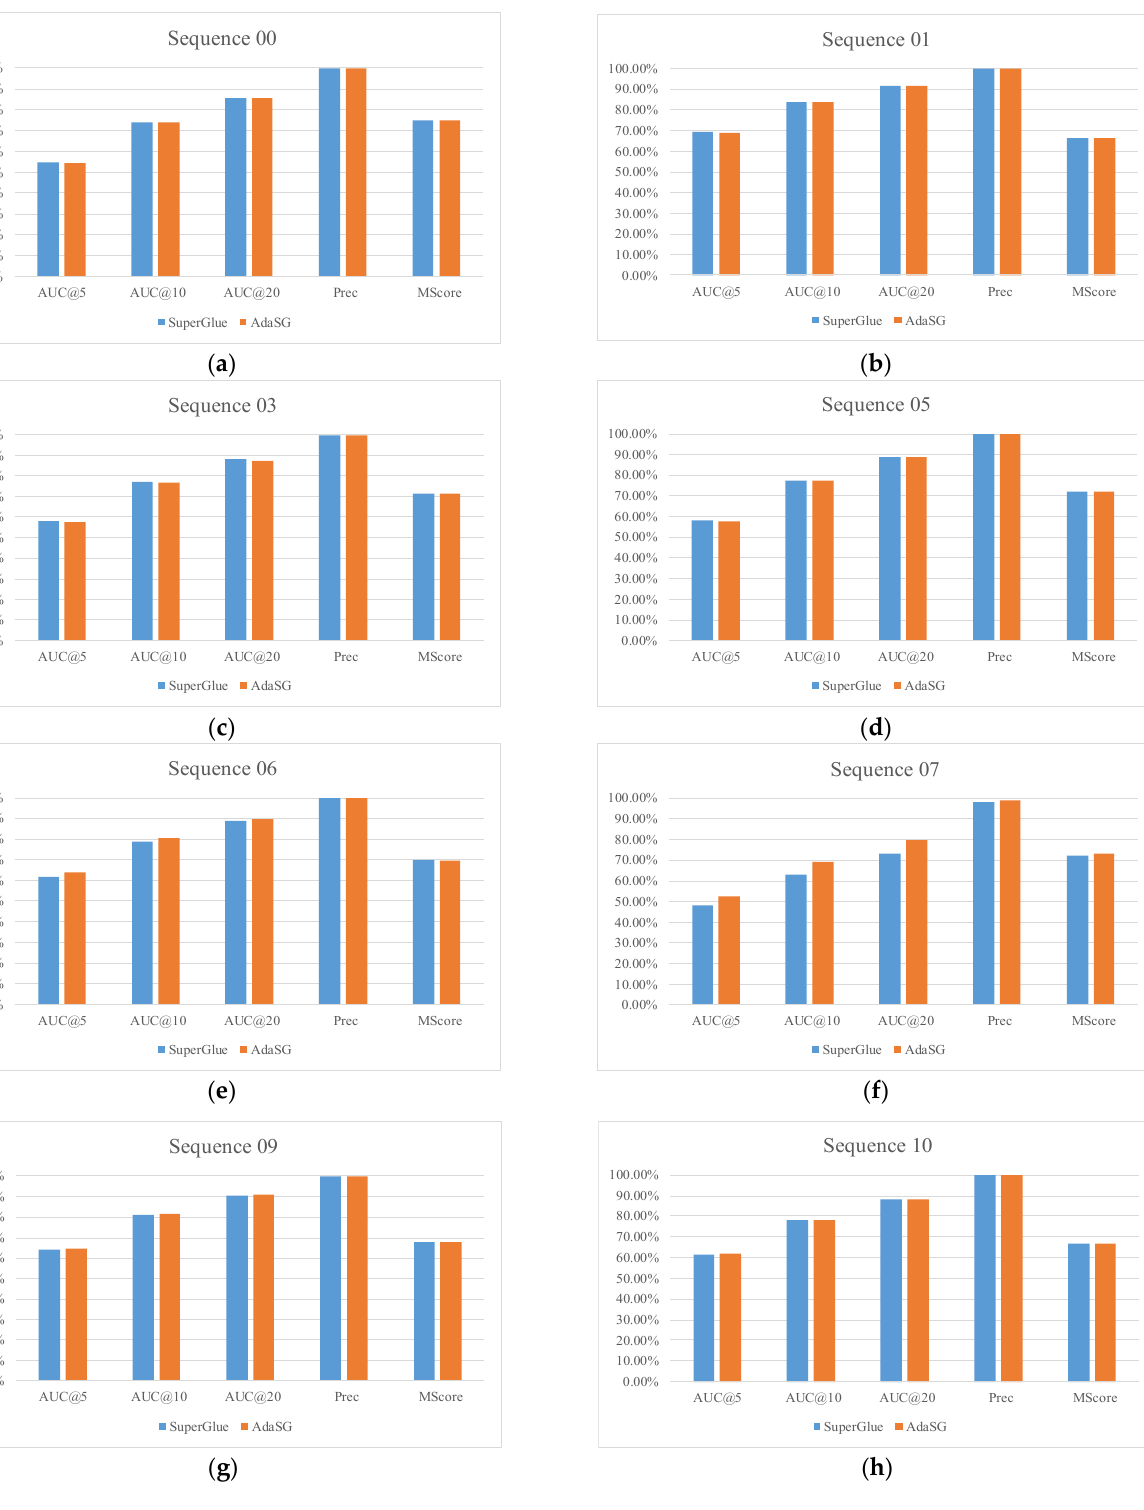
Figure 16. The matching performance for different sequences of KITTI. ( a – h ) is the sequence 00–10 of KITTI, respectively.